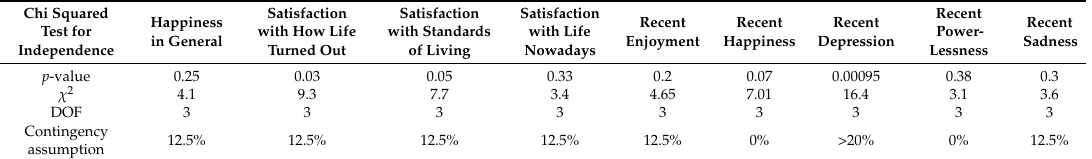
Table 7. Relationship between season and the nine measures of subjective well-being. The results are from the chi-squared test, including p value, chi test value, degree of freedom (DOF), and contingency assumption. All well-being (WB) measures are binary variables.